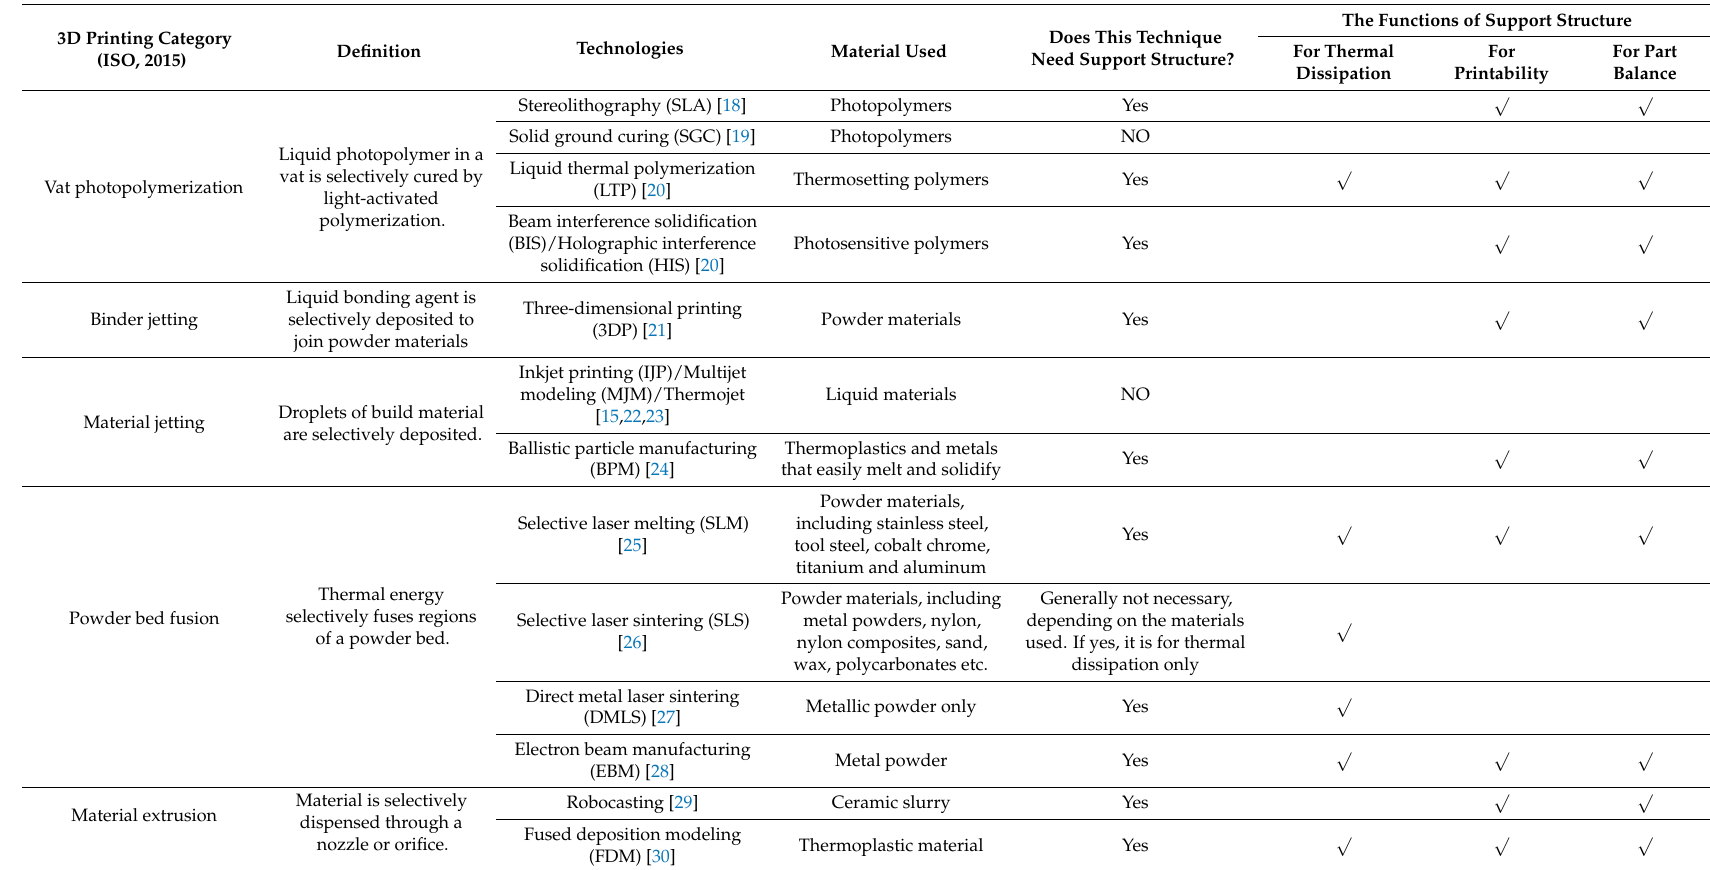
Table 1. Characteristics of 3D printing technologies in support